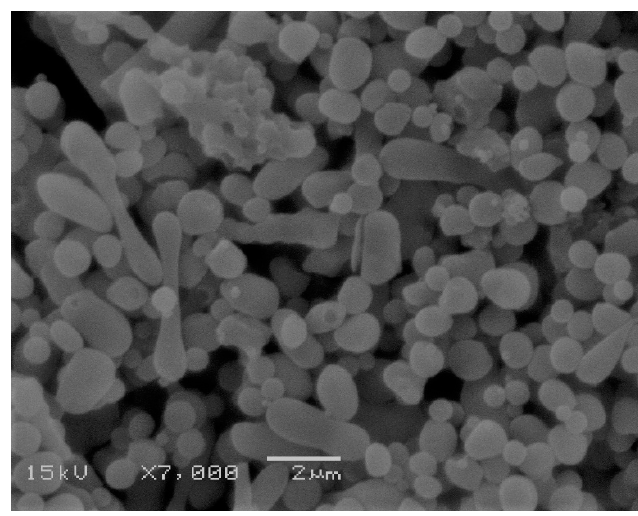
Figure 6. Scanning electron microscopy (SEM) micrograph of lyophilized P-OX4 particles (scale bar = 2 µ m).